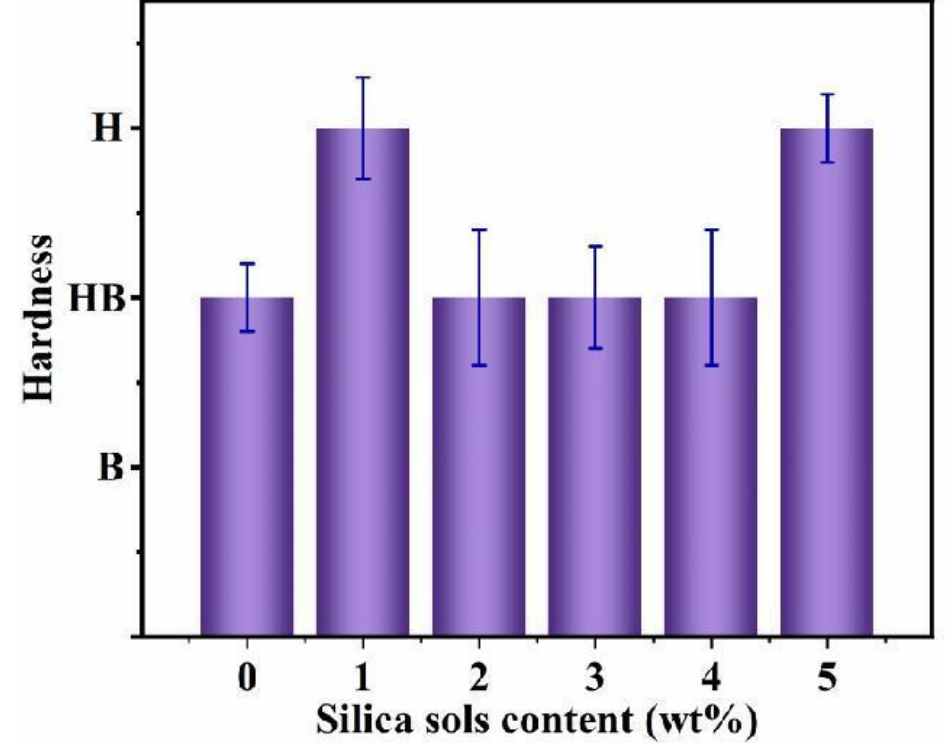
Figure 5. Effect of silica sol content on the hardness of UV-curable WA coatings.